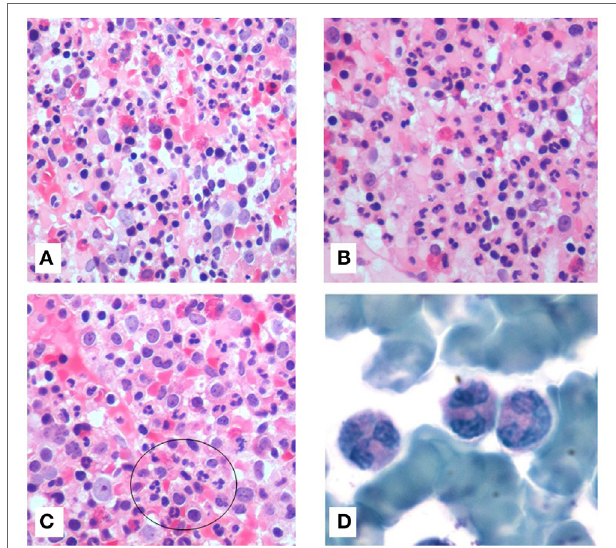
FIGURe 1 | Bone marrow (BM) stained with hematoxylin and eosin (20 × ) showed hypercellularity . All hematopoietic lineages were well represented with marked granulocytes hyperplasia (a) . Presence of high number of eosinophils (B) . Macrophages were loaded of cellular debris referable to cariorexis of polymorphonucleated cells (C) . BM aspirate, stained with Giemsa (100 × ), showed hypermature neutrophils with bizarre form. They were characterized by hypersegmentation of nuclei and long thin chromatin filaments connecting the nuclear lobes (D)